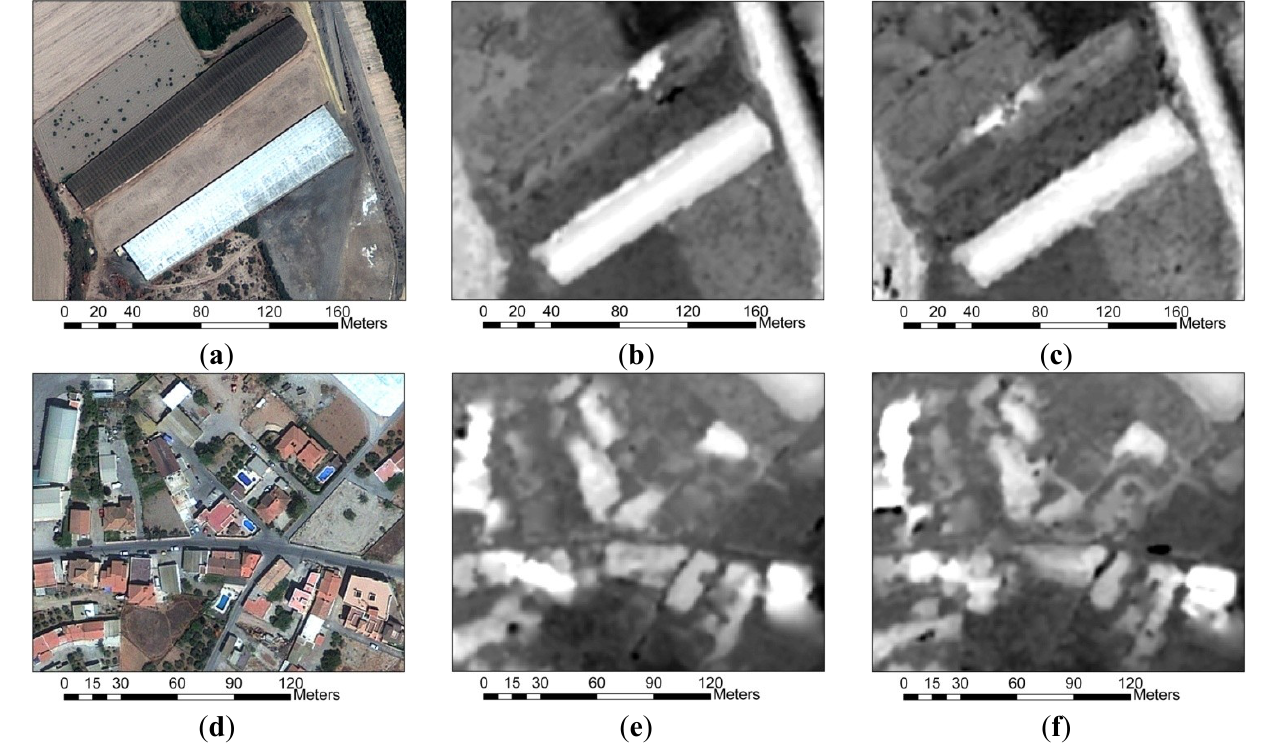
Figure 10. ( a ) Pan-sharpened orthoimage from GE9 focused on greenhouses; ( b ) DSM of greenhouses from the GE1 stereo pair; ( c ) DSM of greenhouses from the WV2 stereo pair; ( d ) pan-sharpened orthoimage from GE9 corresponding to an urban area; ( e ) GE1’s DSM of the urban area; and ( f ) WV2’s DSM of the urban area.